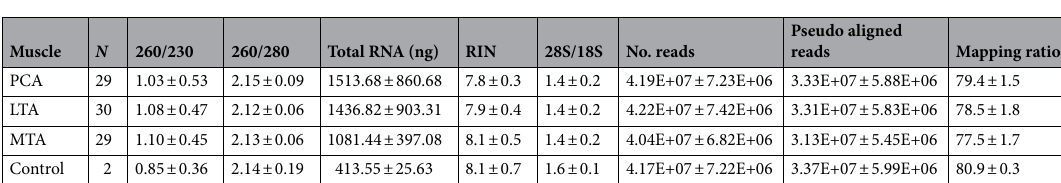
Pseudo aligned reads Mapping